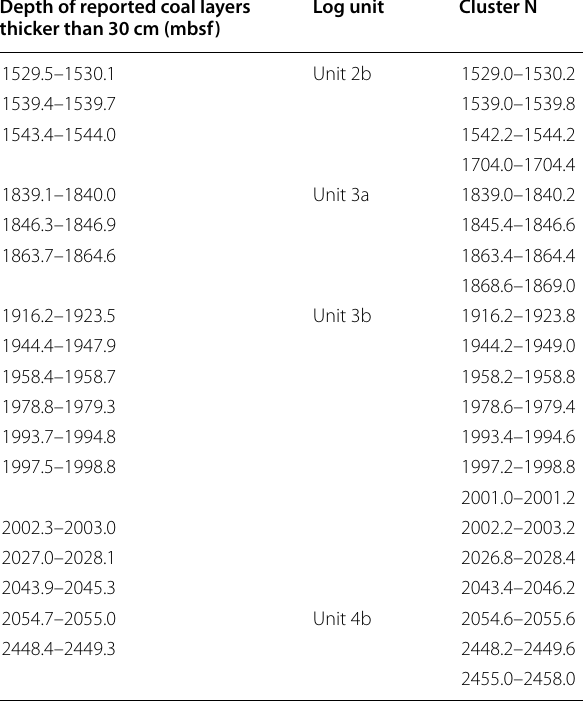
Table 4 Documented coal layers at Site C0020 Depth of reported coal layers thicker than 30 cm